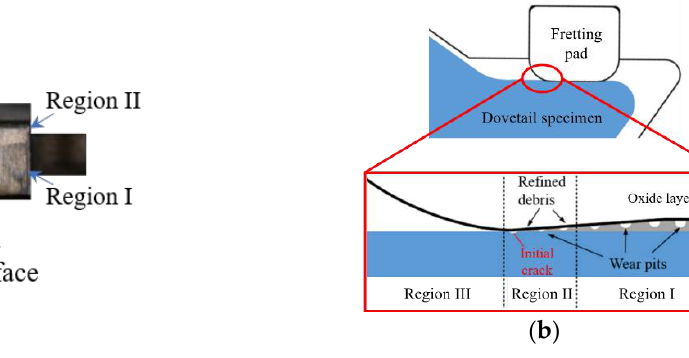
Figure 14. Fretting fatigue damage mechanism for experimental and theoretical analysis. ( a ) Picture of specimens; ( b ) partition of contact surface.